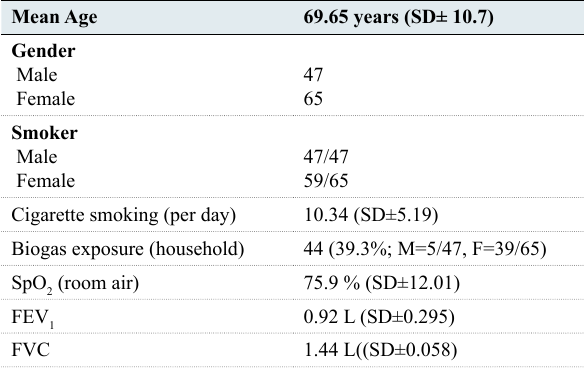
Table 1: Demographic and other relevant findings among